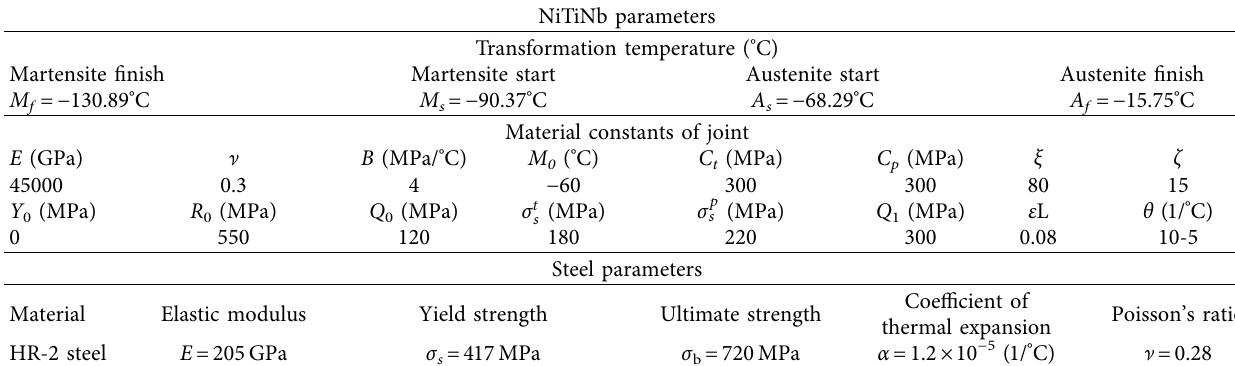
Figure 1: The DSC curves of the initial NiTiNb SMA [8] before predeformation. Table 1: Material parameters of the NiTiNb and the